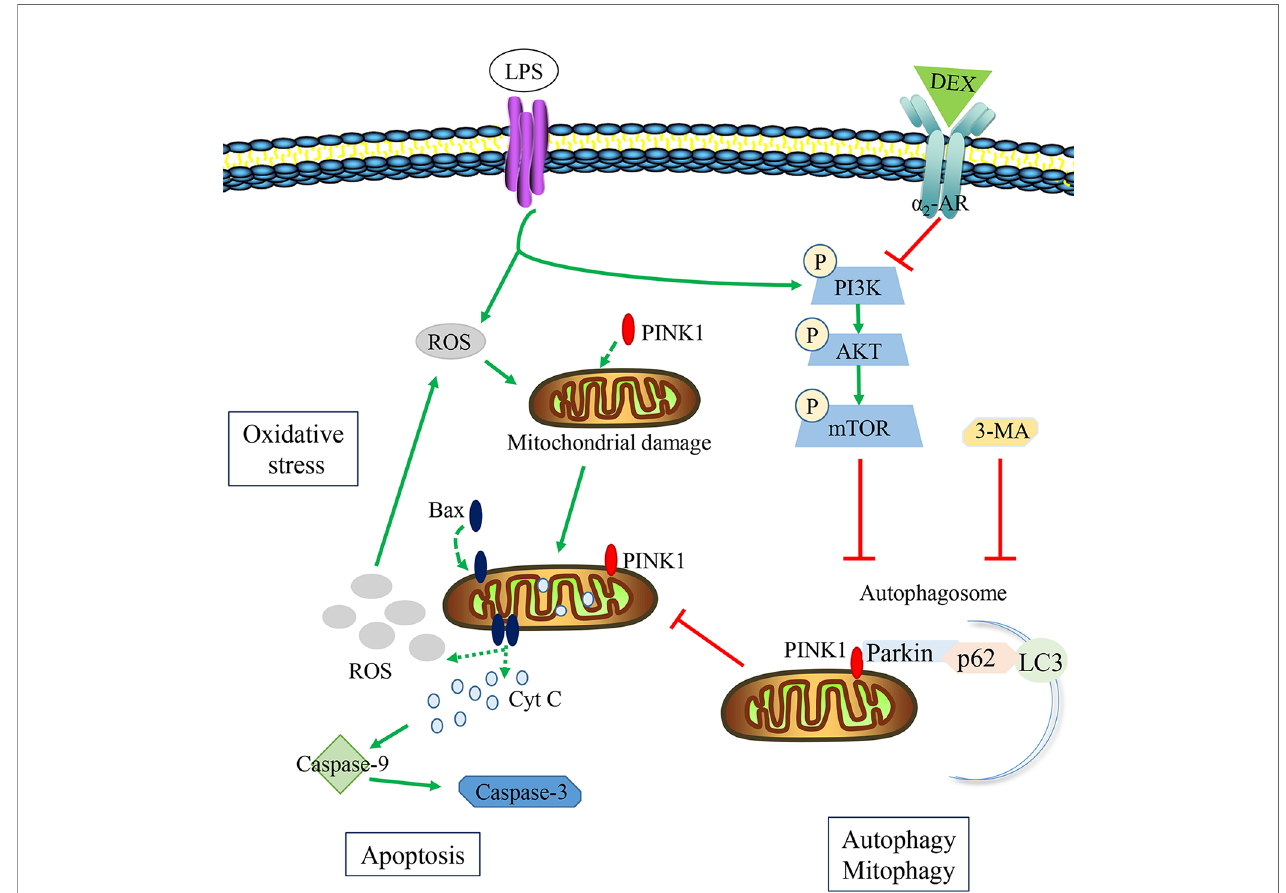
FIGURE 9 | The potential protective mechanisms of DEX in reducing oxidative stress and apoptosis in LPS-induced AKI. LPS could hold back the formation of autophagosome via activating the PI3K/AKT/mTOR pathway, inducing the accumulation of damaged mitochondria. Then ROS and Cyt C released from damaged mitochondria could induce oxidative stress and apoptosis. DEX could inhibit the PI3K/AKT/mTOR pathway to enhance autophagy by a 2 -AR, reducing oxidative stress and apoptosis. 3-MA could inhibit the effect of DEX on